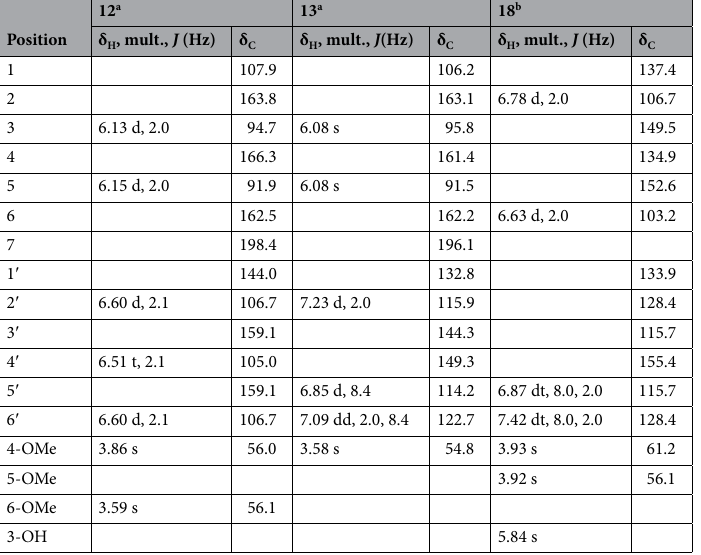
Table 1. 1 H and 13 C NMR data of compounds 12, 13 and 18 . a Measured in acetone-d 6 ; b measured in CDCl 3 .